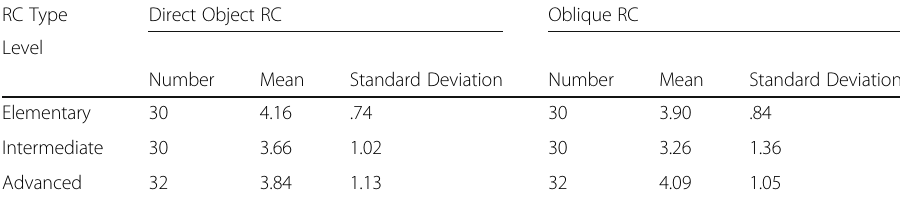
Table 1 Descriptive Statistics of Relative Clause Test Scores for Direct Object and Oblique RC ’ s Across Three